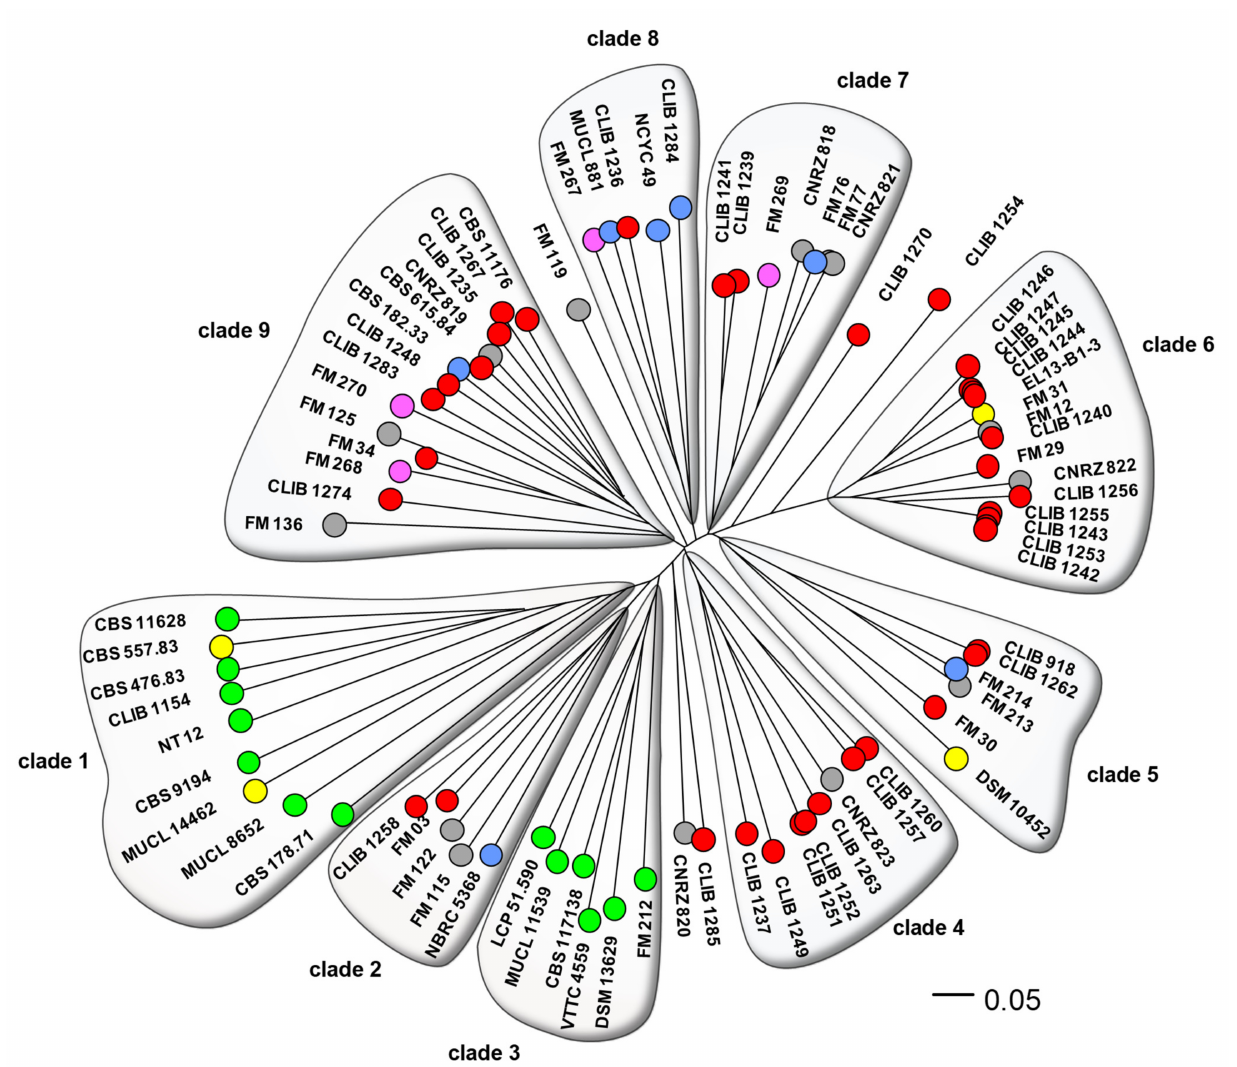
Figure 1. Dendrogram of the G. candidum strains. Phylogeny of the 80 isolates was calculated by the neighbor-joining algorithm using distances calculated according to Edwards and Cavalli-Sforza [22]. Genotypes are represented by coloured circles, according to the isolates’ origins: red, cheese; blue, milk; pink, human stools; yellow, foodstuffs; green, environmental; grey, origin